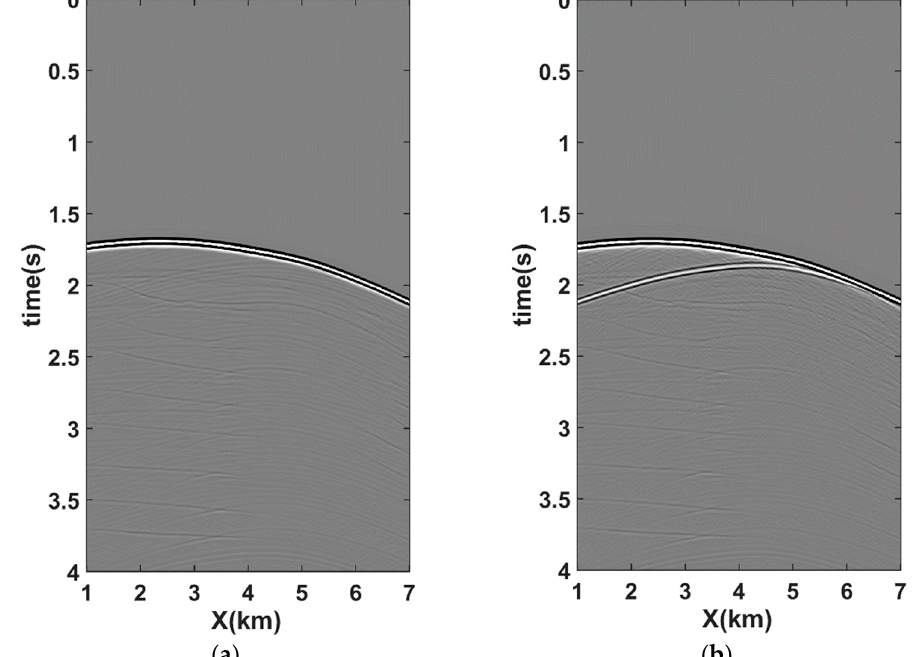
Figure 4. The common receiver gathers corresponding to the virtual receiver (VSP receiver) at x j (X: 2500 m; Z: 5040 m). From ( a ), the standard Marchenko receiver redatuming method retrieved wavefield of Green’s function G ( x j ,x s ) ; from ( b ), the measurement VSP data from direct modeling.